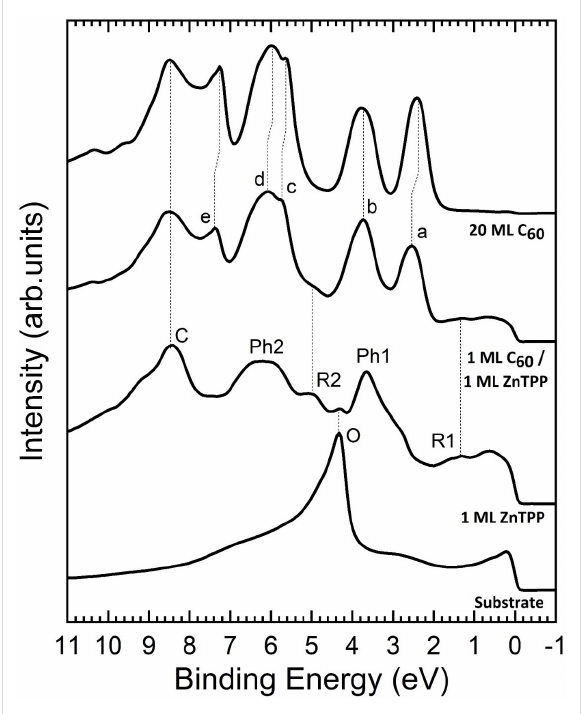
Figure 3: UPS spectra of the system Fe(001)– p (1 × 1)O at different coverages of ZnTPP and C 60 . The lowest spectrum is the one from the bare Fe(001)– p (1 × 1)O. The main features from Fe(001)– p (1 × 1)O (the peak due to oxygen, “O”), ZnTPP (both from the pyrrolic macroring, “R1” and “R2”, and from the phenyl subunits, “Ph1” and “Ph2”) and from C 60 (“a”–“e”) are labeled and their evolution is indicat- ed with dotted lines.